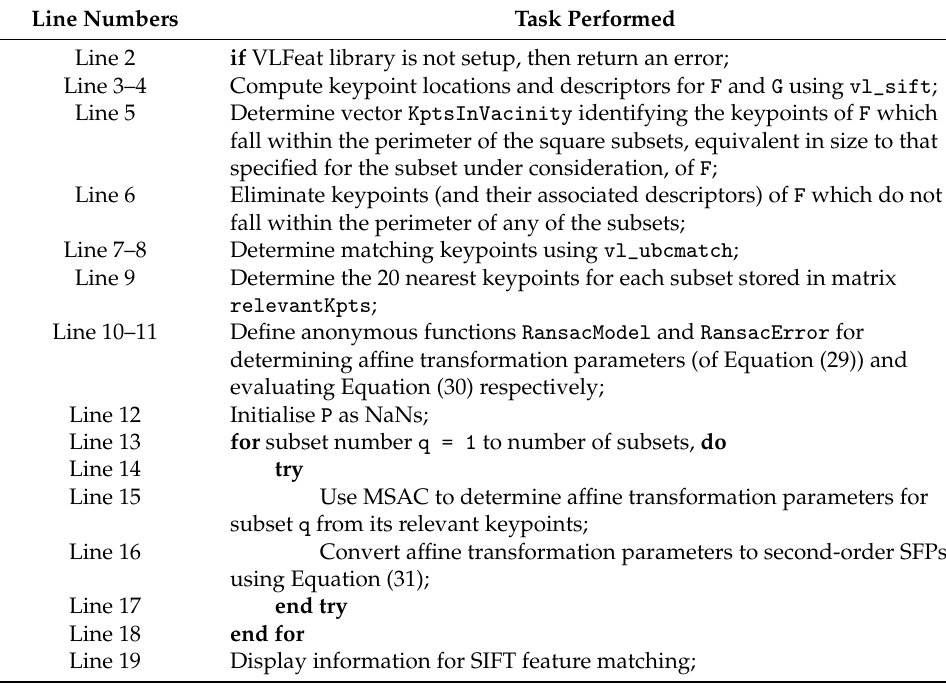
Table 10. FeatureMatch algorithm